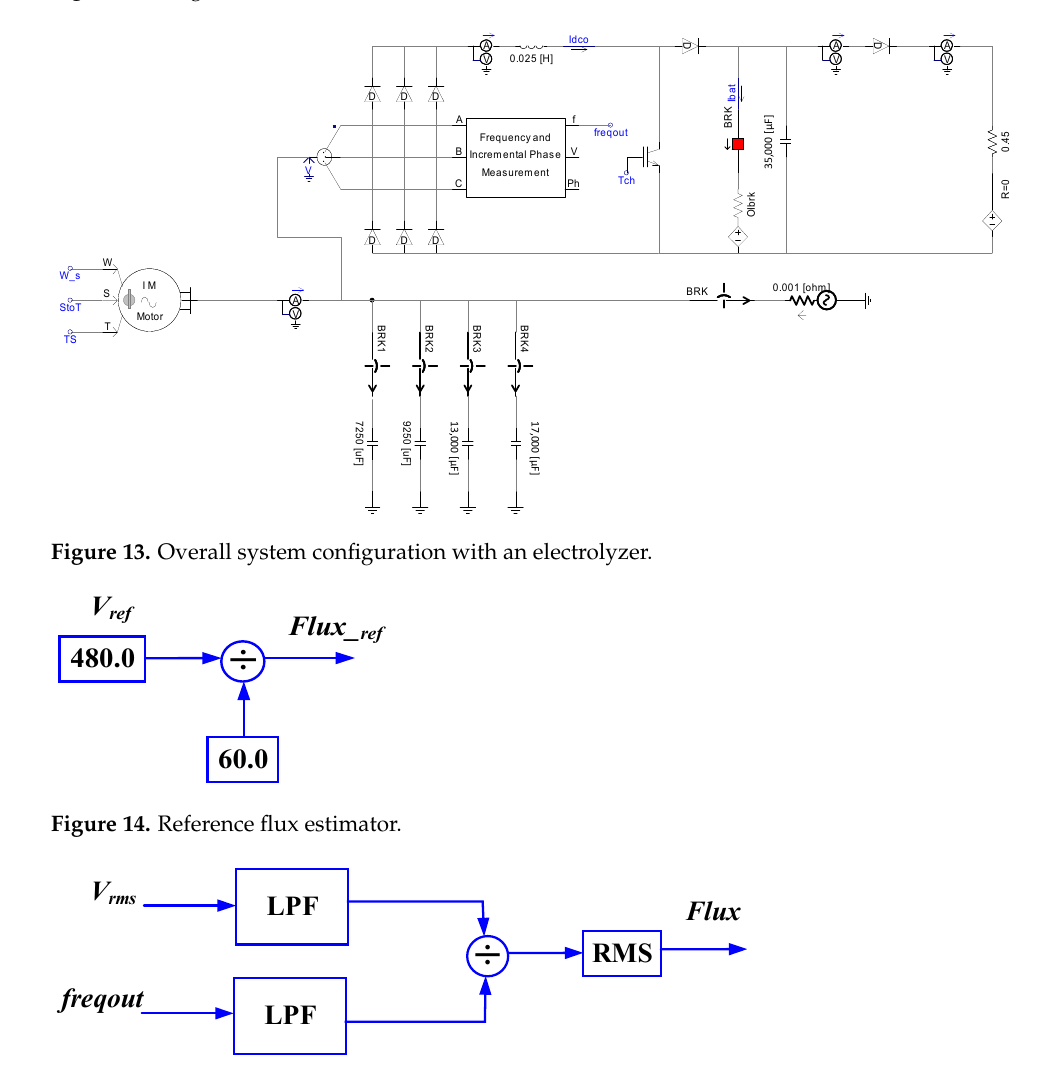
Figure 12. Magnetization curve.